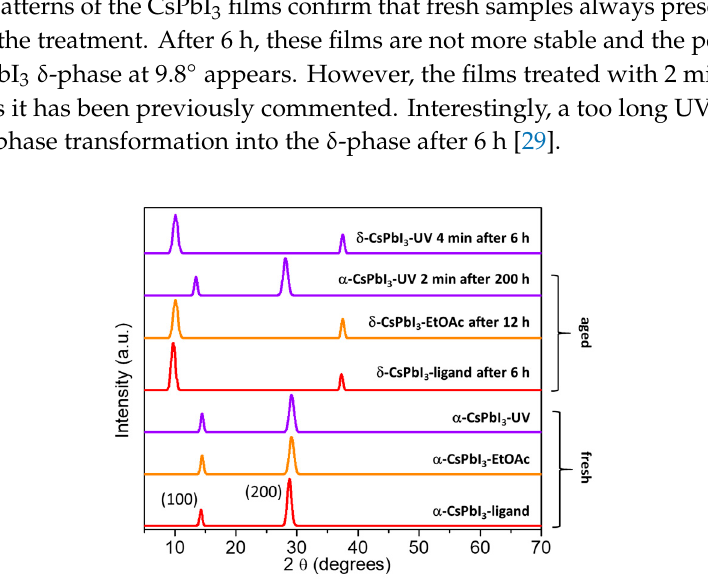
Figure 6. XRD patterns of the CsPbI 3 -ligand (1 layer), CsPbI 3 -EtOAc (3 layers), and UV treated (3 layers) fresh samples and after 7 days in air; different UV exposure times (2 min and 4 min) are reported.